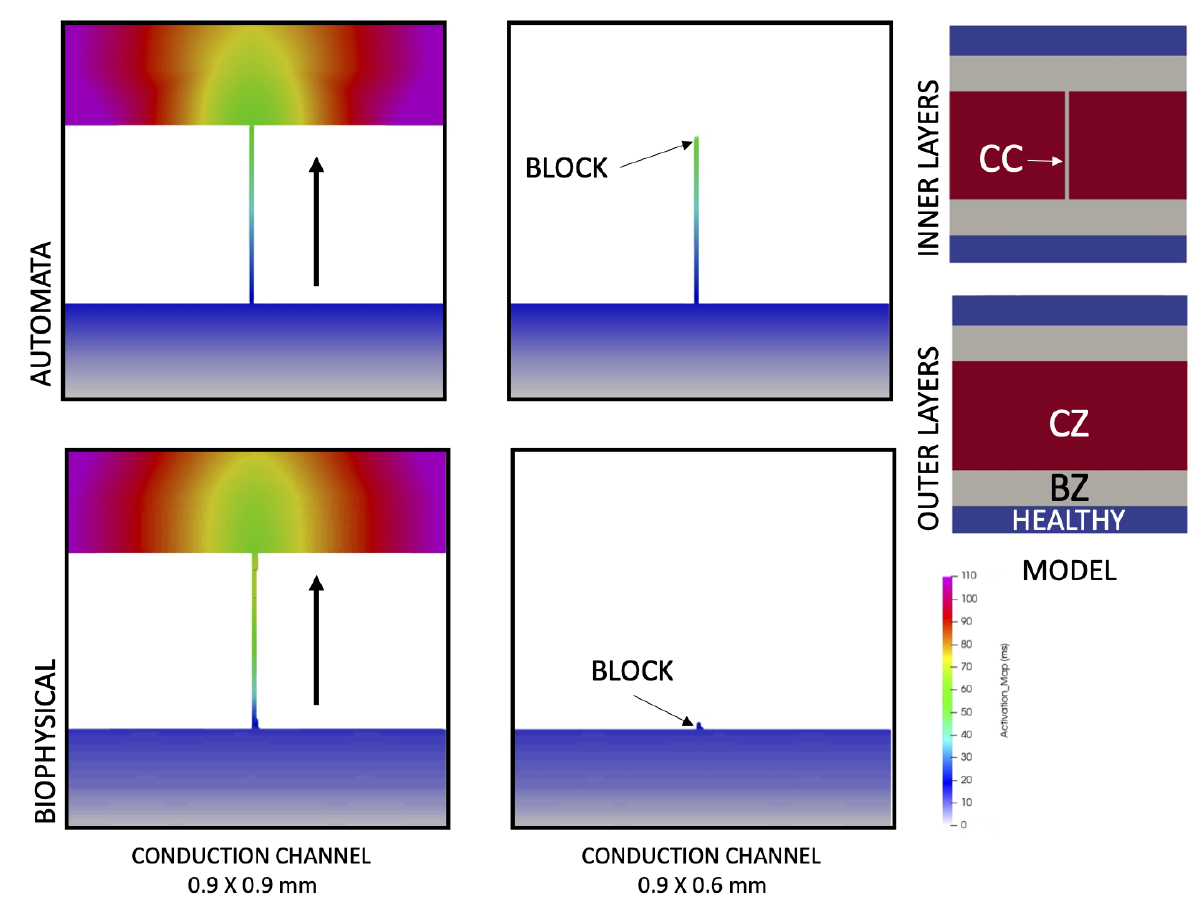
Figure 7. Effect of safety factor on wavefront propagation for channels with different widths. The 3D slab tissue model of several layers containing a conduction channel in the inner layers, healthy tissue (blue), BZ tissue (light gray), and CZ (red); see right legend. Top row corresponds to CA simulations, while bottom row is for biophysical simulations. Columns correspond to an SCC of different width. As observed for an SCC smaller than 0.9 × 0.9 mm, there is a conduction block. Elements in the model are hexahedral of 0.3